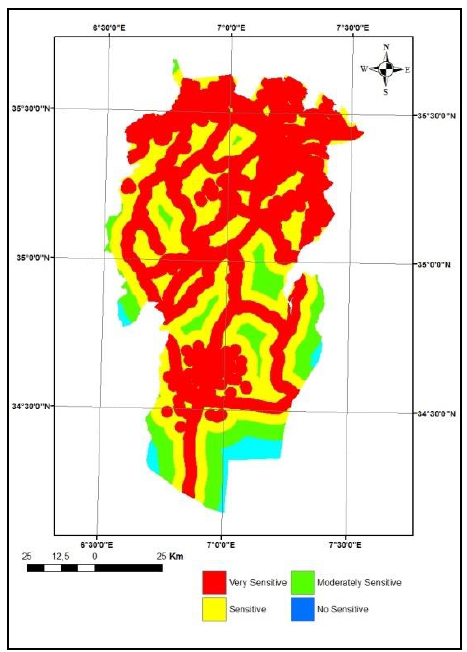
Figure 6. Map of sensitivity of an ecosystem agro- forestry-pastoral vis-à-vis the human impact.